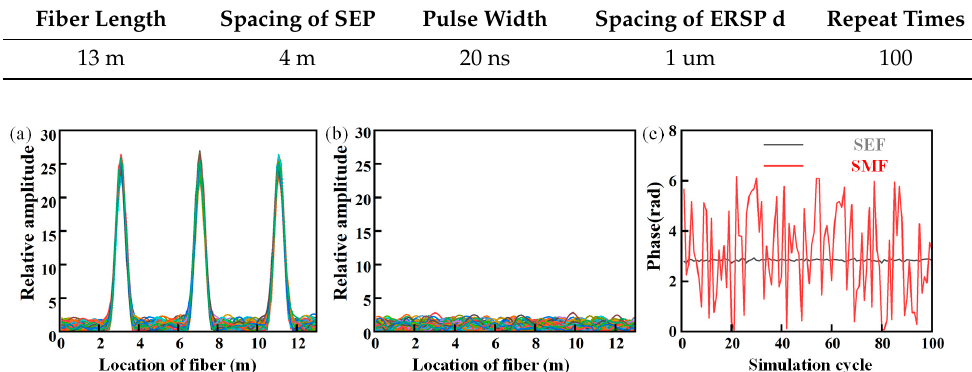
Table 1. Parameters of discrete enhanced scattering model.